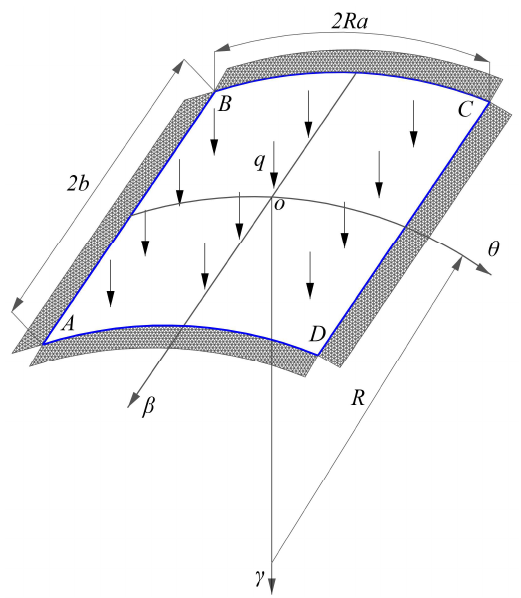
Figure 1. The bimodular cylindrical shell under transversely uniformly distributed load.